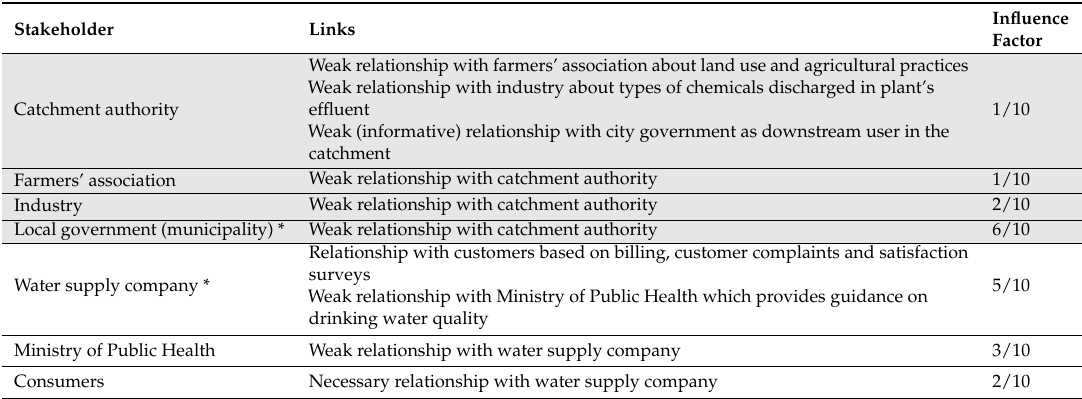
Table 1. Stakeholders’ interconnections and influence factors in decision